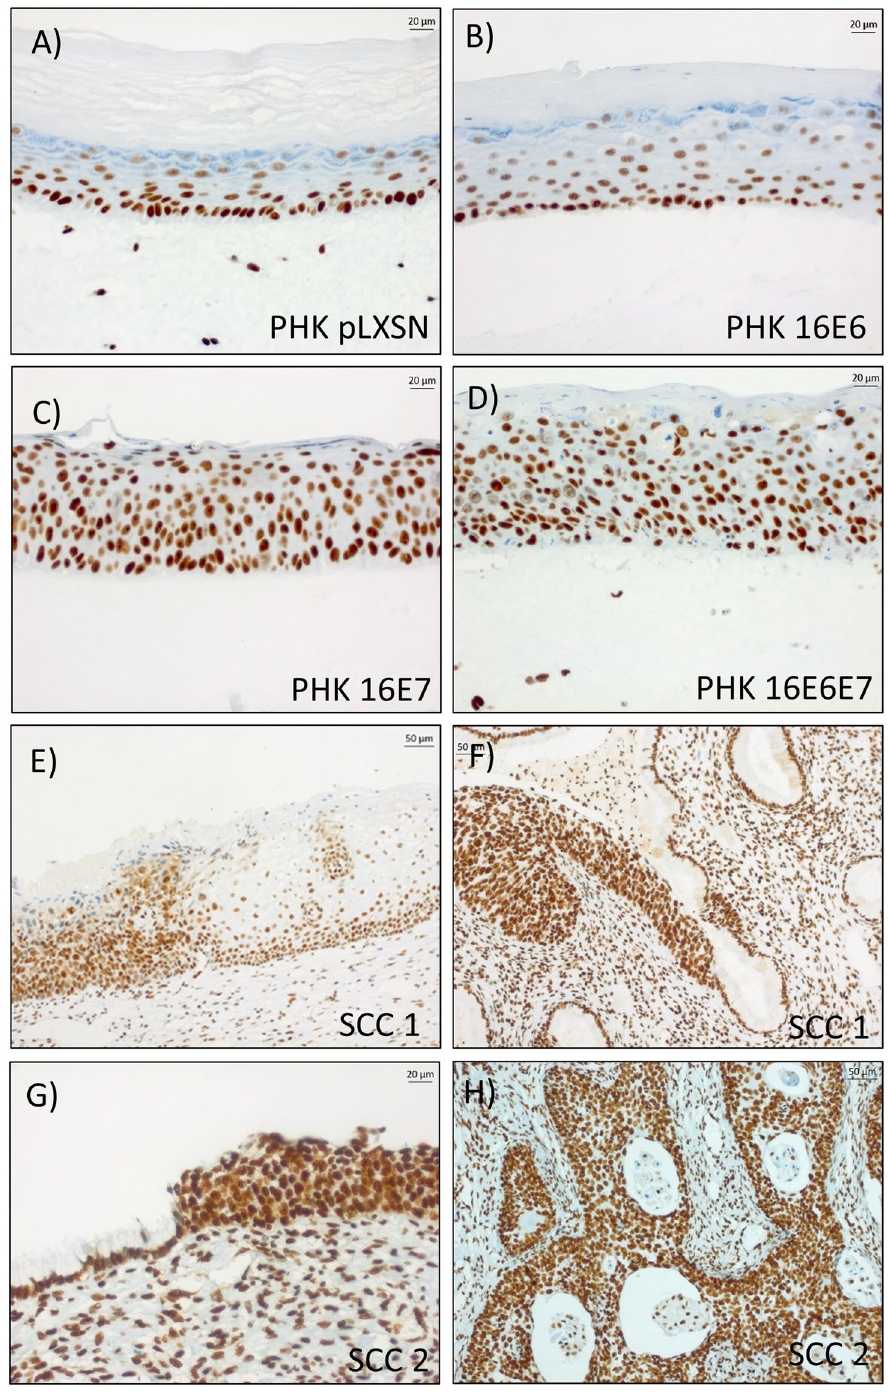
Figure 3. HMGB1 is upregulated in epithelial rafts expressing HPV16 E7 and in squamous cell carcinomas. The expression of HMGB1 was determined by immunohistochemistry in organotypic cultures sections of ( A ) control; ( B ) HPV16 E6 expressing; ( C ) HPV16 E7 expressing and ( D ) with HPV16 E6E7 expressing keratinocytes and in squamous cell carcinomas ( E , F ) sample 1 and ( G , H ) sample 2. Note limit area between normal epithelium and high-grade lesion ( E , G